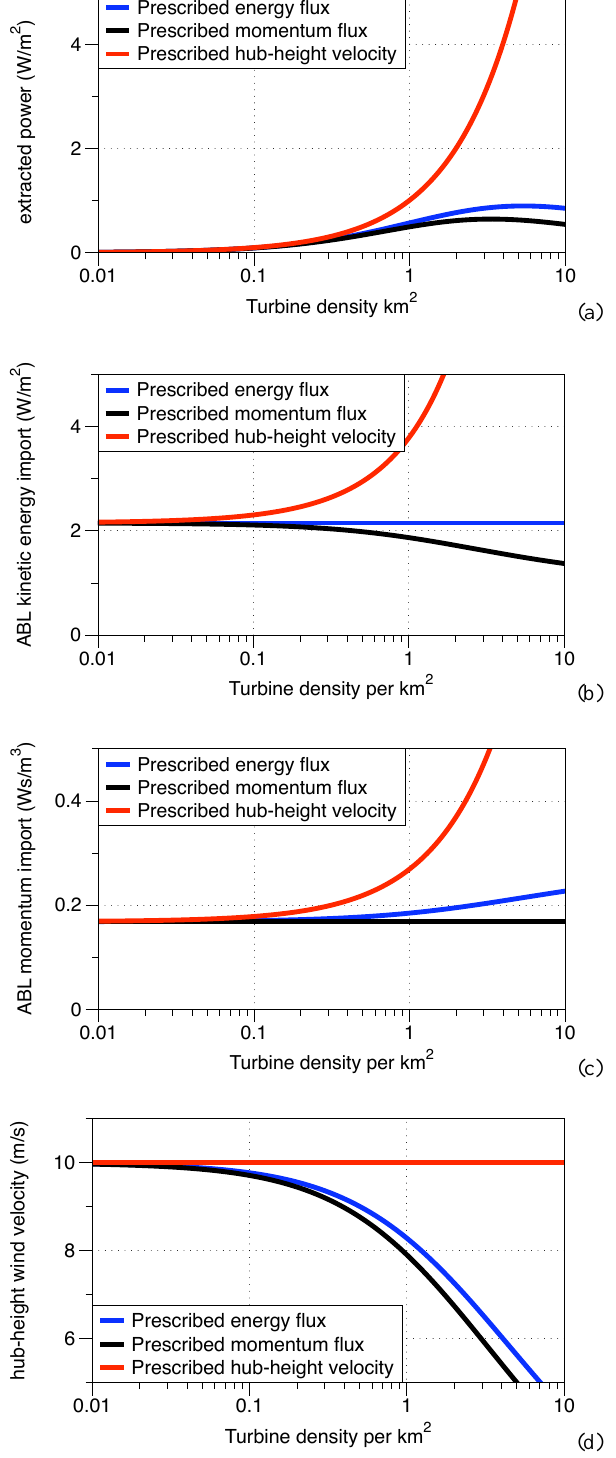
Fig. 2. Comparison of the simple atmospheric boundary layer model results under 3 different assumptions represented by different col- ors. The graph shows the turbine power extraction (Wm − 2 ), kinetic energy import at the top (Wm − 2 ), momentum import at the top (Wsm − 3 ) and wind velocity at hub-height (ms − 1